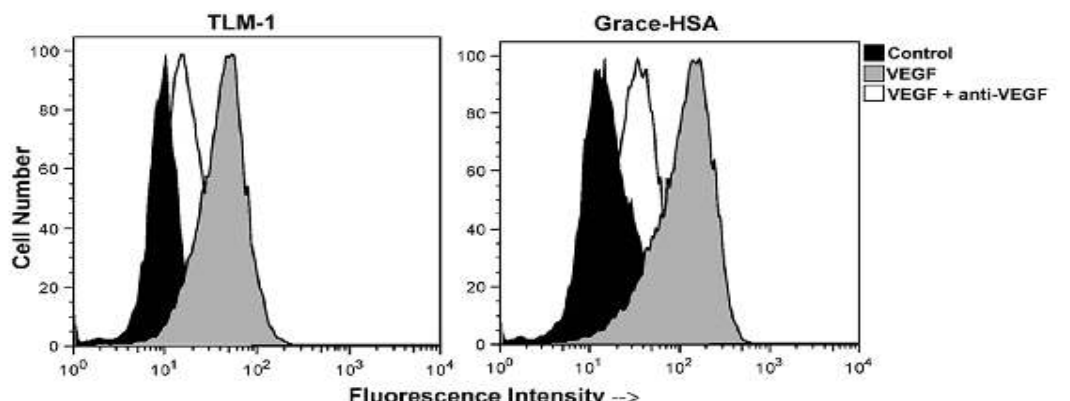
Figure-3. VEGF-A binds to both VEGFR1 and VEGFR2. One dimensional histograms illustrating fluorescence (x-axis) relative to cell number (y-axis) for both cell lines. The black peak represents the negative control. The grey peak represents human recombinant VEGF conjugated to fluorescein isothiocyanate (FITC). The white peak represents VEGF with blocking from anti-VEGF antibodies, to illustrate specificity. VEGF binding was measured using the human VEGF biotinylated fluorokine kit (R&D Systems, Minneapolis, MN) and cells were analyzed using a FACSCalibur cytometer (BD Biosciences, San Jose,